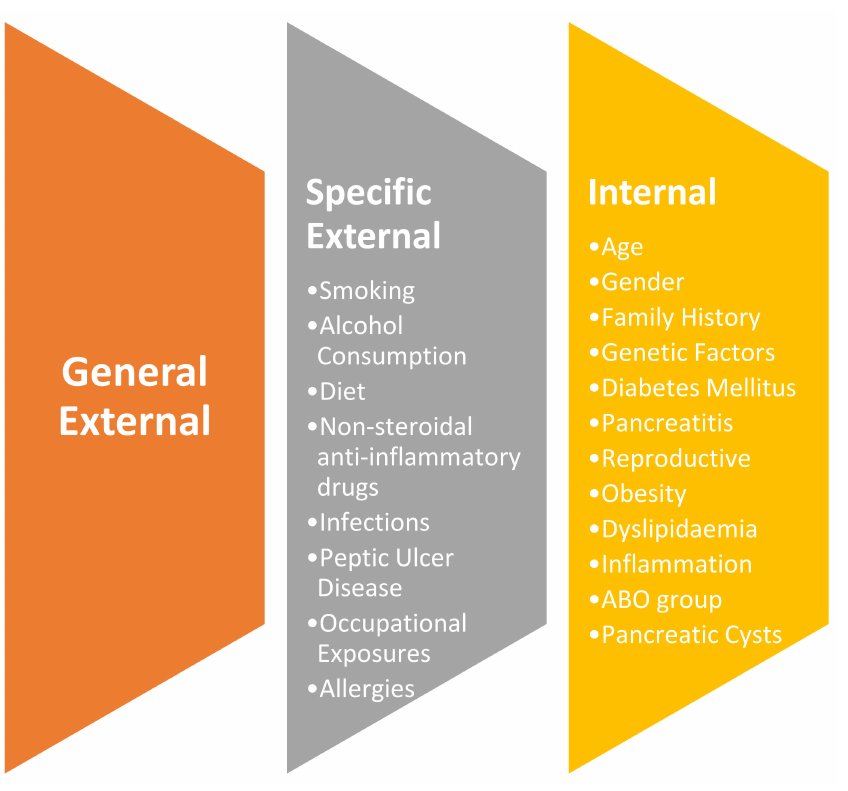
Figure 3. Overview of the internal, specific external and general external exposome factors for pancreatic cancer described in the review. Table 2. Summary of the exposures that define the PCa exposure profile. Strength of association is defined by the number of studies reporting on the association, the range of the hazard ratio/odds ratio/relative risk/standardized incidence ratio reported in each study, and the statistical